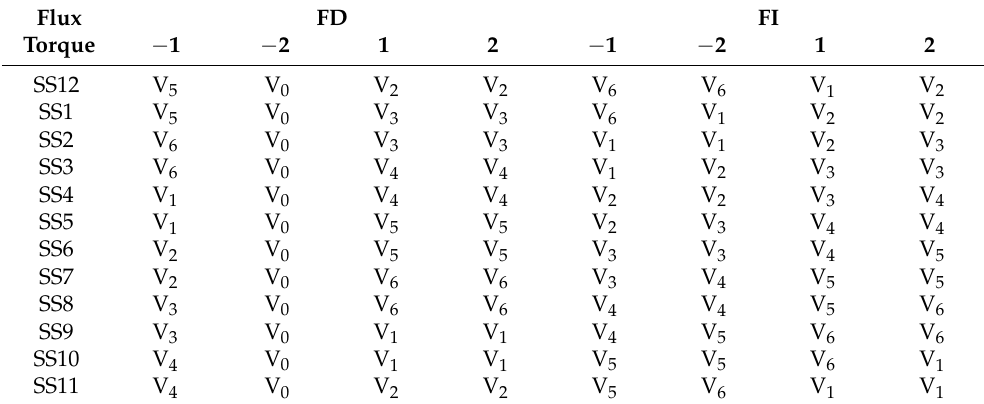
Table 2. The switching table of the proposed DTC. Flux FD FI Torque